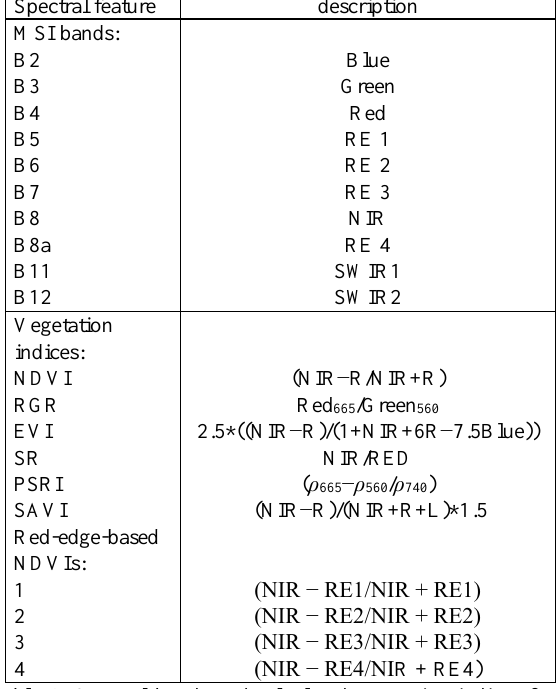
Table 1. Spectral bands and calculated vegetation indices from Sentinel-2 MSI.